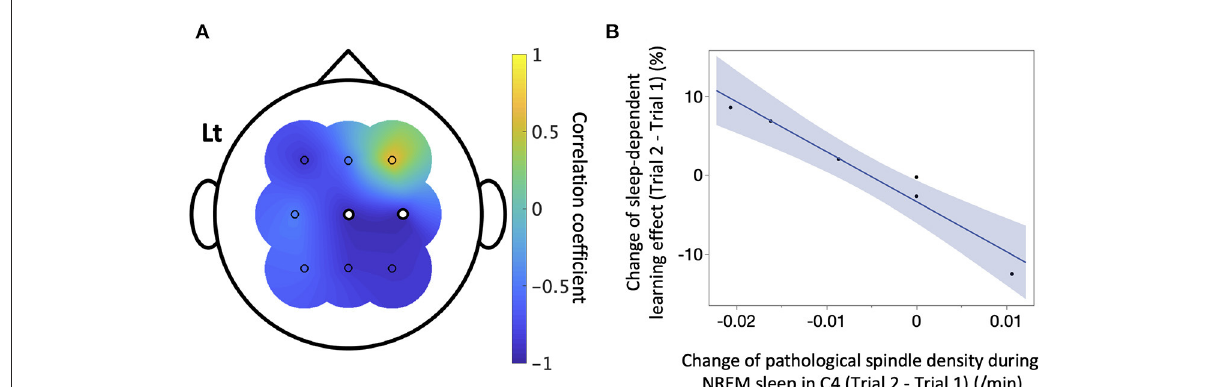
FIGURE6 The correlation between sleep-dependent learning effect and pathological spindles. In the six patients with interictal epileptic discharges (IEDs), a simple linear regression analysis was conducted between the change between Trials 1 and 2 of sleep-dependent learning effect and that of IED-coupled spindle density of each electrode. (A) The correlation coefficient is shown here. There was a significant negative linear correlation in C4 ( β = − 634, 95%CI = − 858 to − 410, P = 0.019), marked as white dots. (B) A scatter plot of the result for C4 is